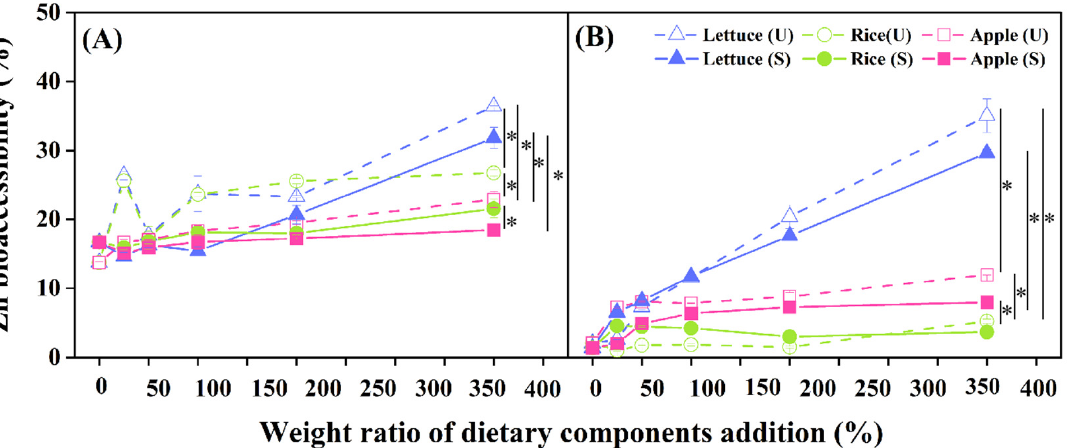
Figure 2. Bioaccessibility of Zn in the gastric ( A ) and intestinal ( B ) phases after addition of different dietary components before (U) and after (S) FeSO 4 stabilization. Data are presented as the mean ± standard deviation (S.D.) of the three experimental groups. ANOVA analysis reveals the statistical differences between the stabilization treatments and dietary addition groups. An asterisk (*) indicates significant difference between the different dietary addition groups ( p < 0.05). Summary of statistical information including p values is given in Table S4.